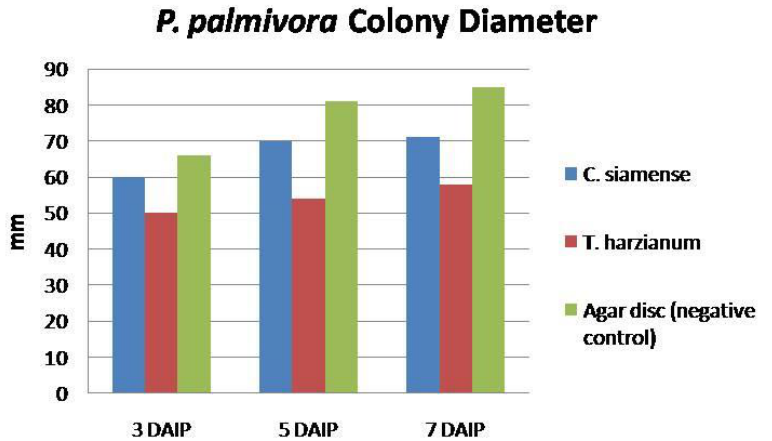
Figure 4. Mycelial growth (mm) of P. palmivora as affected by C. siamense at 3, 5 and 7 days after inoculation